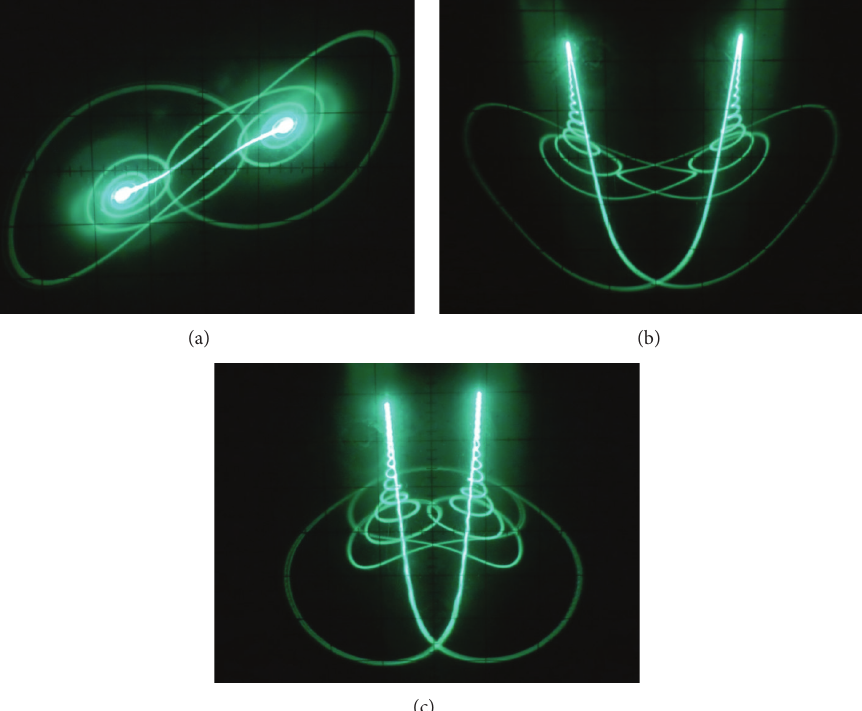
Figure 11: Multiperiodic orbit shown in the phase portraits of the system (6) with 𝐴 = 1.4 V and 𝑓 = 385 Hz: (a) 𝑥 - 𝑦 plane; (b) 𝑥 - 𝑧 plane; (c) 𝑦 - 𝑧